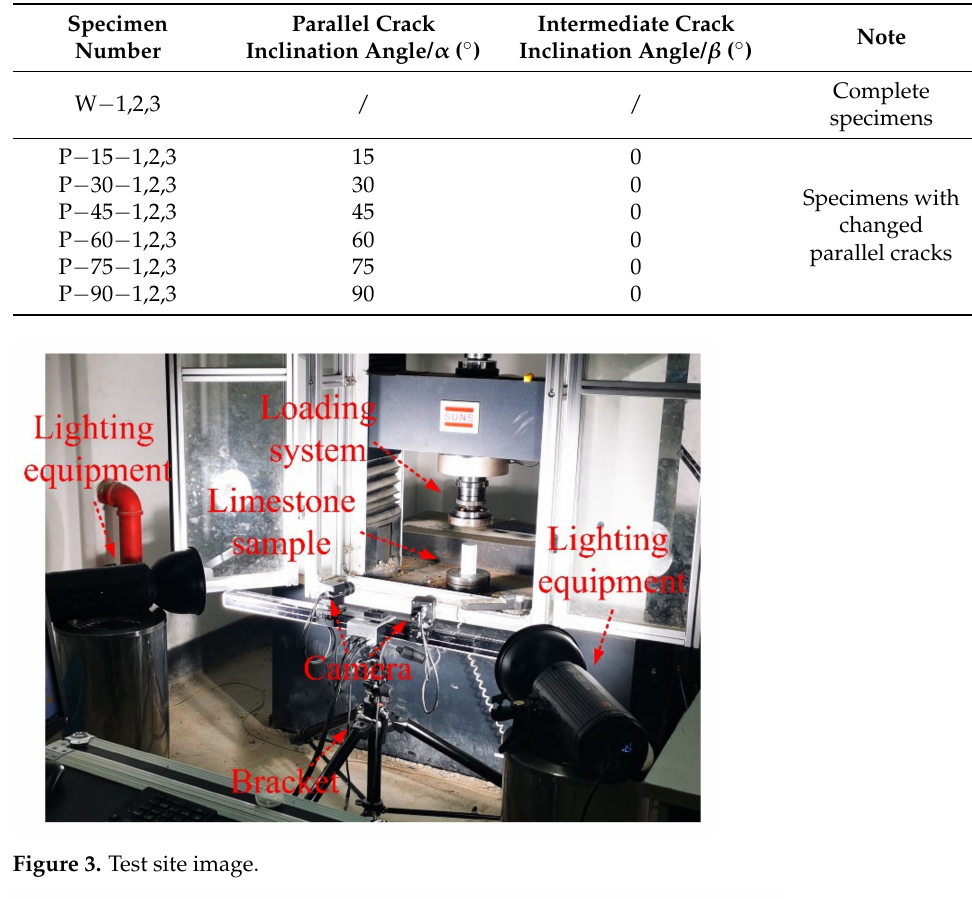
Table 1. Test scheme.